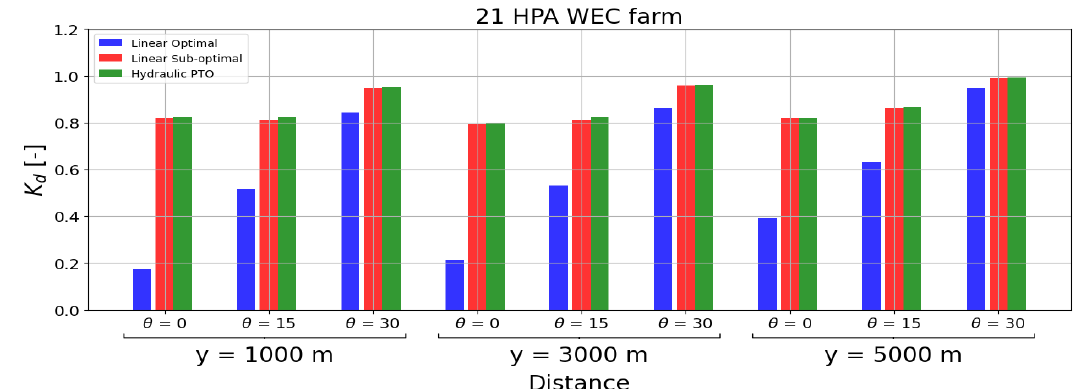
Figure 9. Bar chart showing the minimum K d disturbance coefficient for a 21 HPA farm with a linear optimal PTO (blue, first bar), a linear sub-optimal PTO (red, second bar) and a hydraulic PTO (green, third bar), interacting with regular waves of H = 2.0 m, T = 8.0 w and θ = 0 ◦ , 15 ◦ and 30 ◦ , respectively. The minimum K d is obtained along the three transversal